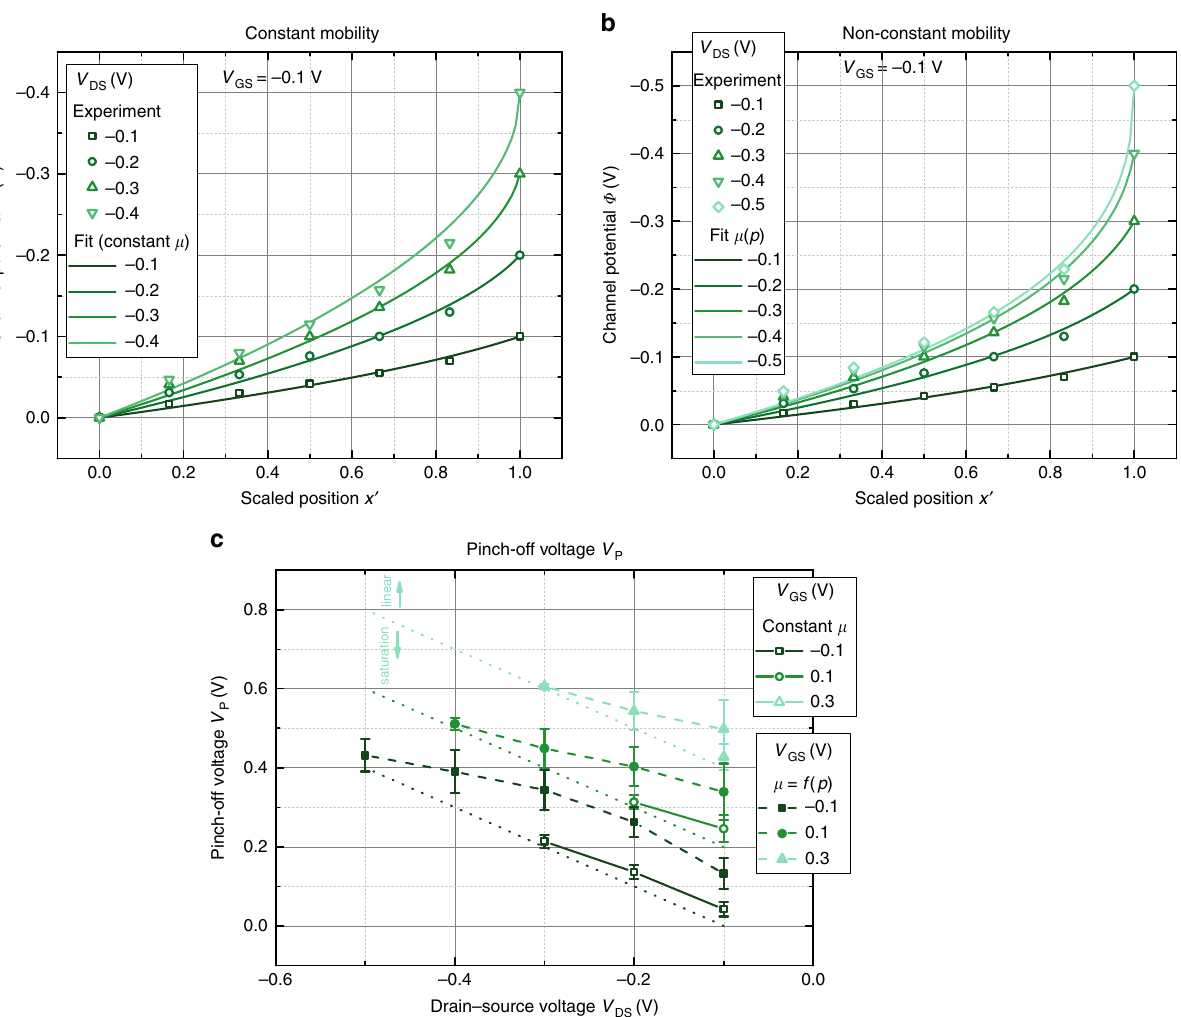
Fig. 3 Fitting the channel potential. a Channel potential Φ ð x 0 Þ at V GS = − 0.1 V fi tted by Eq. (8), that, assuming a constant mobility. b Channel potential Φ ð x 0 Þ at V = − 0.1 V fi tted by Eq. (9), that is, assuming a mobility that depends on the hole concentration (Eq. (3) with E 0 GS extracted from the fi ts for constant mobility (open symbols) and a mobility that depends on the hole concentration (closed symbols). The dotted lines denote the transition form of the linear to the saturation regime of the transistor for the different gate voltages. A satisfying fi t can only be found if the pinch-off voltage is adjusted for every applied